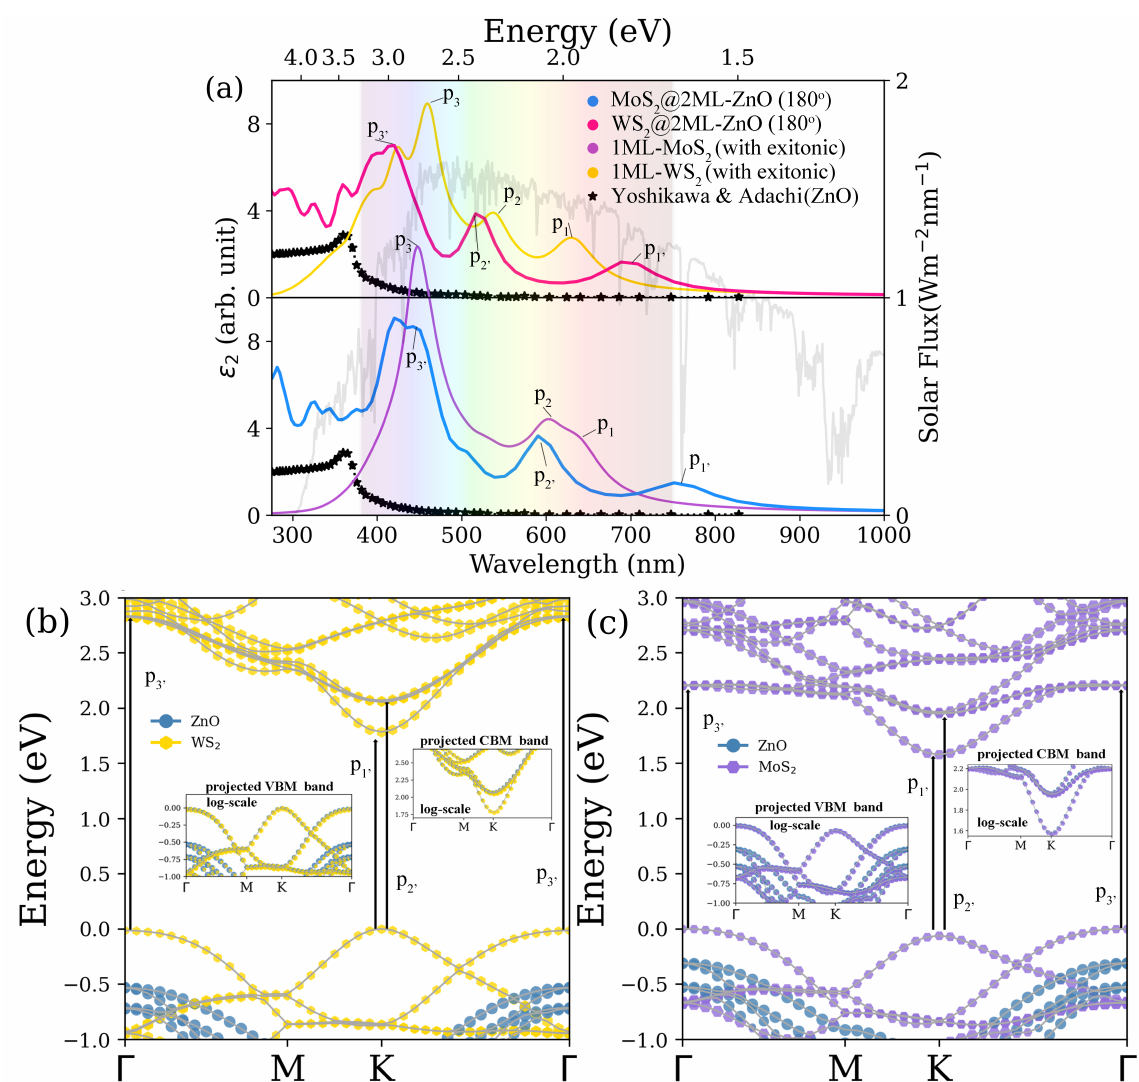
Figure 9. Enhancement of imaginary part of dielectric function ( ε 2 ) in comparison with free-standing ZnO and TMDs MLs ( a ) and the projected band structures of MoS 2 @2ML-ZnO ( b ) and WS 2 @2ML- ZnO ( c ) as calculated by means of GLLBSC E XC . The upper and bottom panels in ( a ) show the MoS 2 @2ML-ZnO and WS 2 @2ML-ZnO, respectively, with the rotation angle of 180 ◦ . The ε 2 of ZnO bulk and TMD MLs are the same as shown in Figures 3 and 5. The insets in ( b , c ) indicate the log-scale of projected band contributions for TMDs MLs and 2ML-ZnO substrates around VBM and